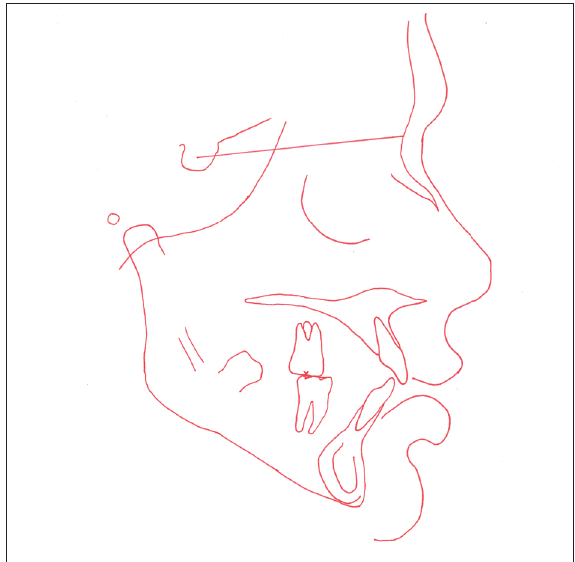
Figure 8. Tracing of final lateral cephalometric